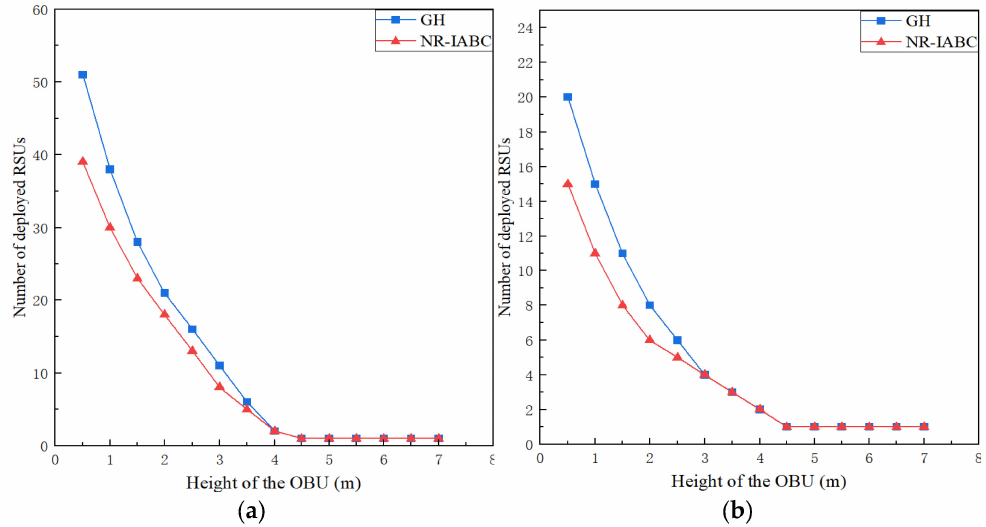
Figure 5. The impact of different b 0 under two different conditions: ( a ) γ = 0.1, D s = 23; ( b ) γ = 0.1, D s =